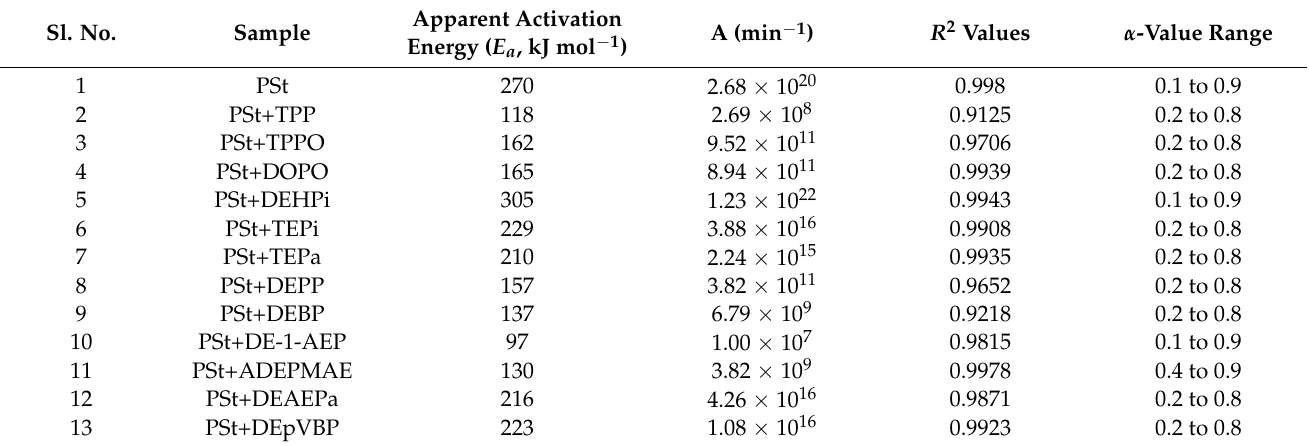
Table 3. Energy of activation ( E a ) and other relevant parameters of PSt-based samples obtained using the software (model: F1 First